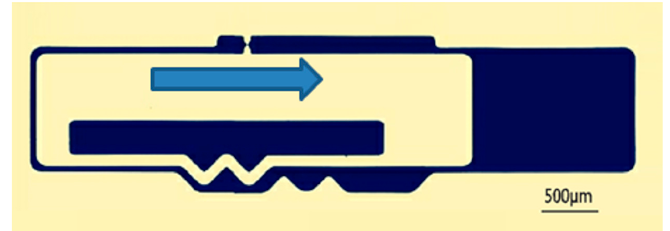
Figure 16. The direction of centrifugal acceleration.